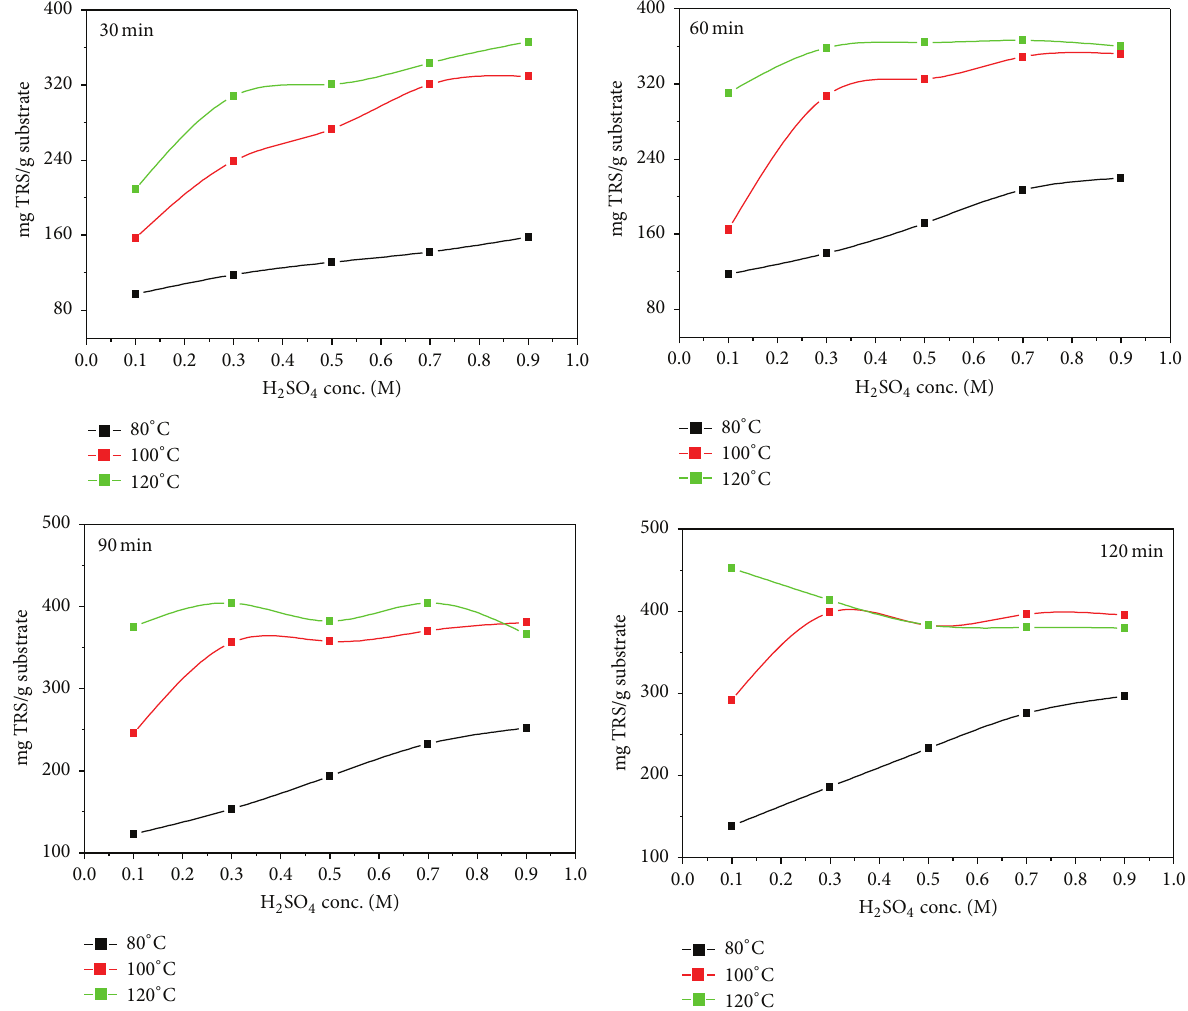
Figure 3: Effect of temperature and H 2 SO 4 concentration at different reaction time on the production of TRS from sugarcane bagasse.